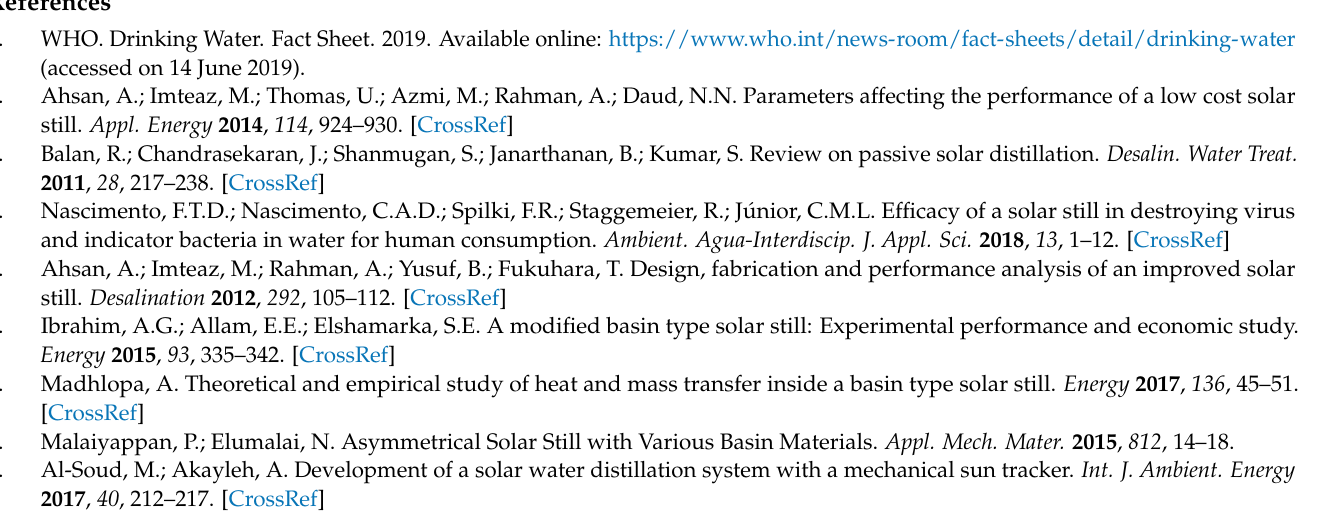
Figure S3: Plots of model diagnostics of Con-Still (Model